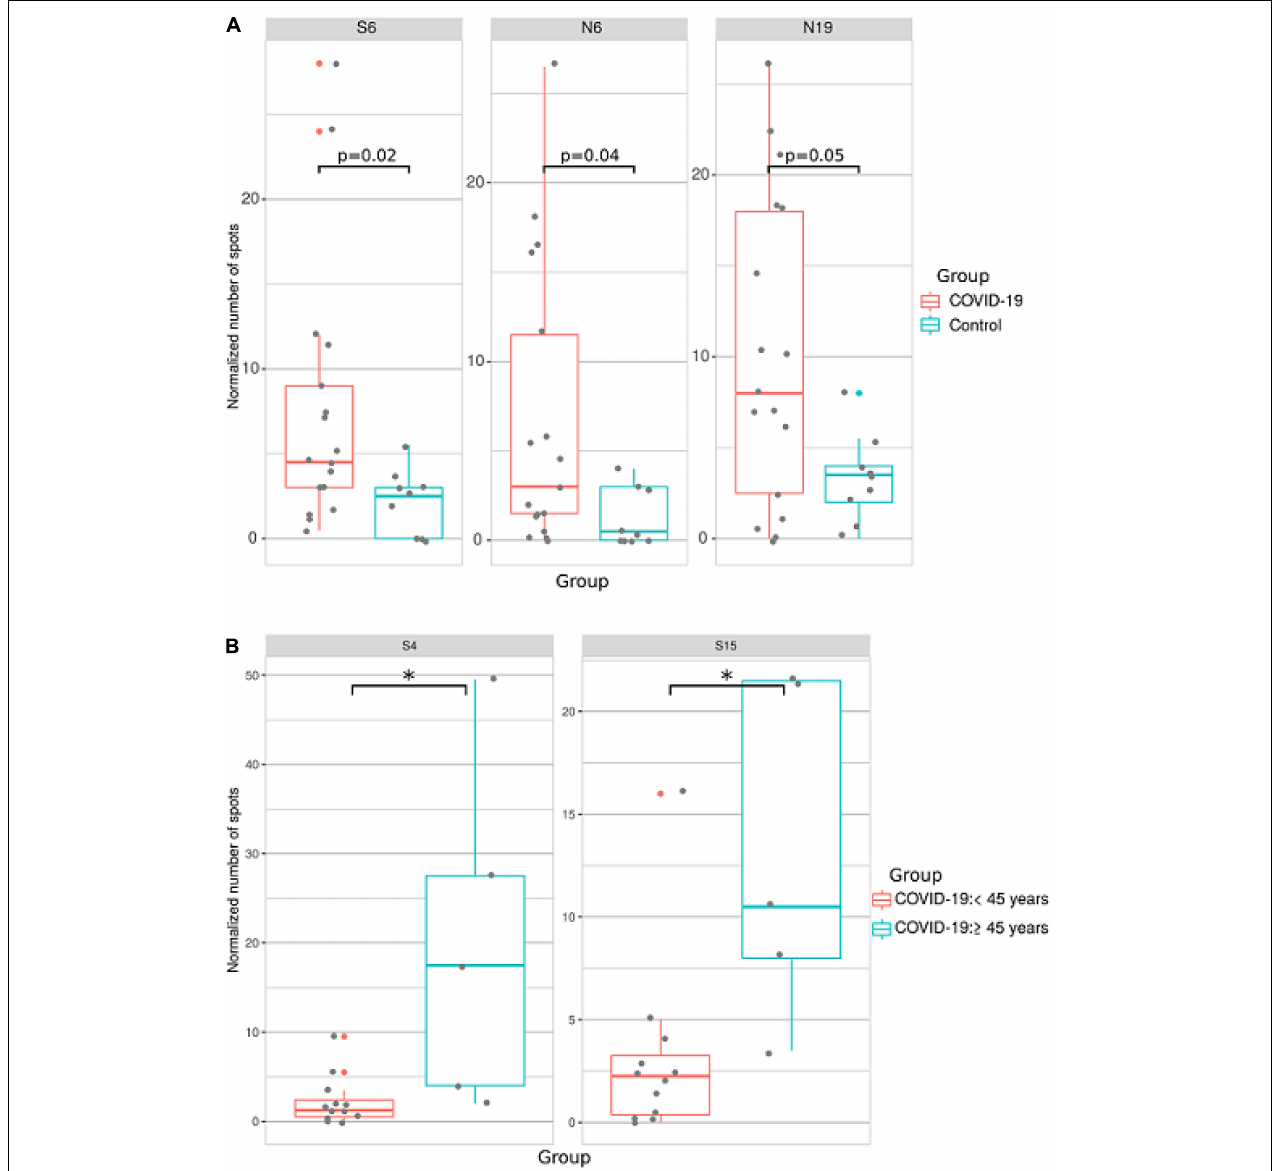
FIGURE 7 | Analysis of T cell reactivity to SARS-CoV-2 peptides using ELISpot. PBMCs were collected from COVID-19 convalescent individuals and incubated with COVID-19 T cell peptides in anti–human IFN- γ mAb-coated 96-well plates. Spots were detected with biotinylated anti-human IFN- γ antibodies after 48 h. The number of spots in negative control wells was subtracted from the number of spots in stimulated wells. All experiments were done in duplicate. (A) Analysis of T cell reactivity to SARS-CoV-2 peptides in all COVID-19 patients. (B) Analysis of T cell reactivity to SARS-CoV-2 peptides in younger ( < 45 years old) and older ( ≤ 45 years old) COVID-19 patients. Asterisks indicate statistically significant differences between reactivity to SARS-CoV-2 peptides depending on age of the patient ( p < 0.05, Kruskal-Wallis